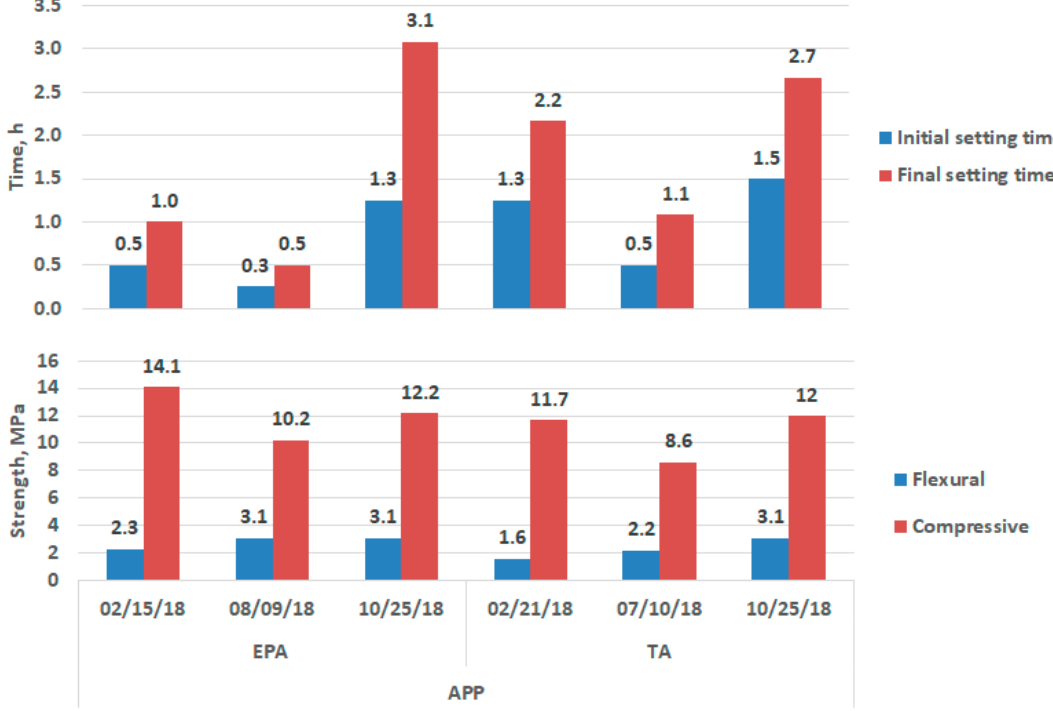
Figure 5. Setting times and Self-cementitious ability for APP-EPA and Figure 5. S etting times and Self-cementitious ability for APP-EPA and APP-TA.